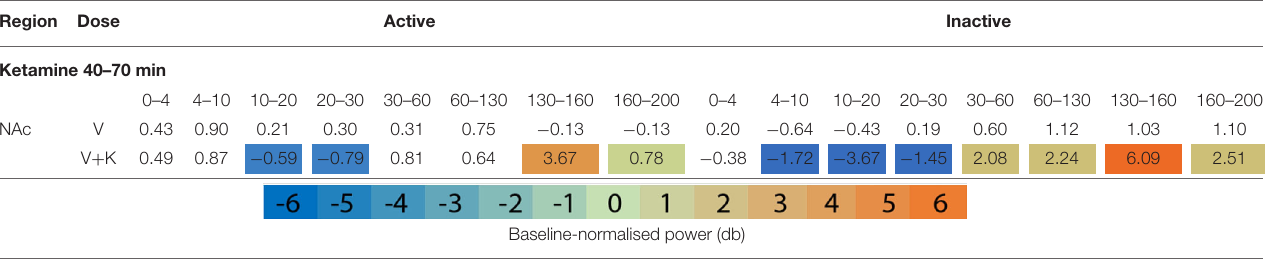
TABLE 1 | Tables of averaged power spectra between 40 and 70min of experimentation for “Inactive” and “Active” epochs of animals given vehicle pre-treatment (at 0min) + vehicle or ketamine (10 mg/kg at 30min). Region Dose Active